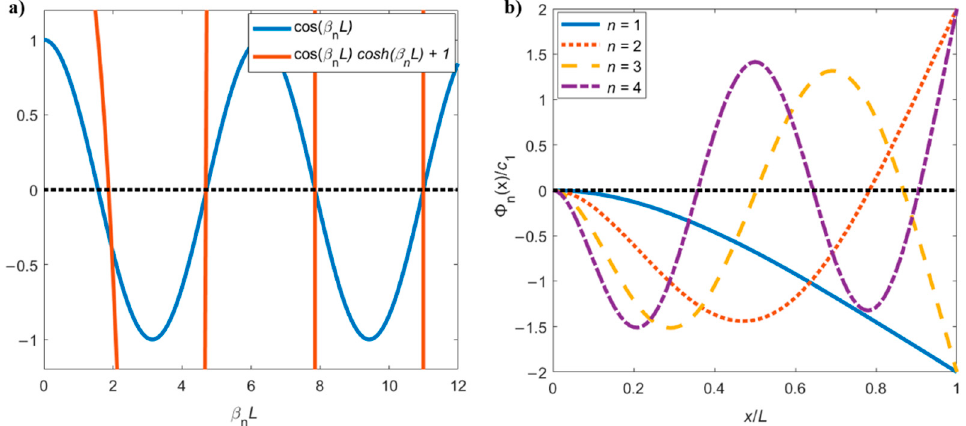
Figure 2. ( a ) Plot of Equation (10) (orange line), whose first four solutions β n L (indicated in the text) are the crossings with zero. The blue line shows the asymptotic approximation cos ( β n L ) = 0, which can be solved analytically, and that agrees with the numerical solution for n ≥ 2; ( b ) mode shapes of the first four flexural modes of a cantilever.